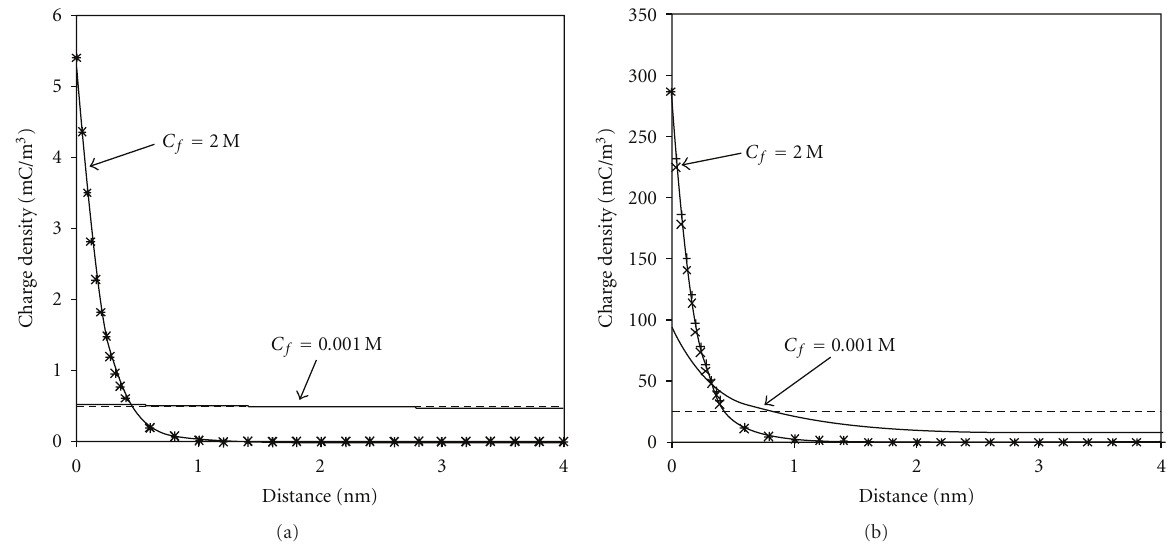
Figure 2: Excess charge density ( Q ) as a function of distance from the capillary centre ( x ) in a circular capillary of radius 4 nm, for a surface charge of (a) 1mC · m − 2 and (b) 50mC · m − 2 . Each plot shows results for electrolyte salinities of 0.001 M and 2M, corresponding to dimensionless capillary radii of 0.41 (i.e., towards the limit for which the thick double layer assumption is valid) and 21.6 (i.e., towards the limit for which the thin double-layer assumption is valid). Solid lines show Q obtained from a numerical solution of the Poisson-Boltzmann equation (1) in conjunction with (16); crosses show Q obtained from an analytic solution to the Poisson-Boltzmann equation assuming a thin double-layer (diagonal crosses show the Gouy-Chapman model given by (24); vertical crosses show the Debye-H¨uckel model given by (7)); dashed lines show constant Q assuming a thick double